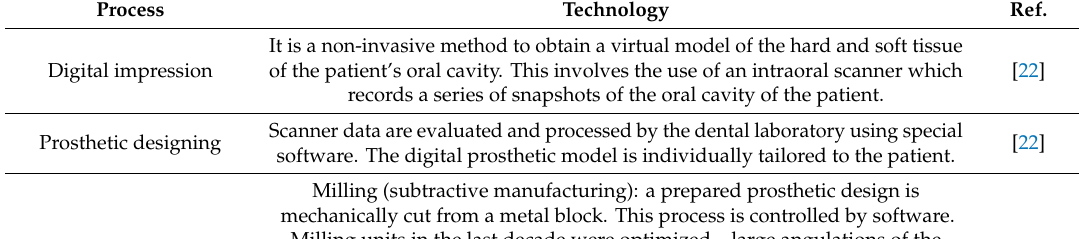
Table 1. Computer-aided design / computer-aided manufacturing (CAD / CAM) processes currently upgraded into